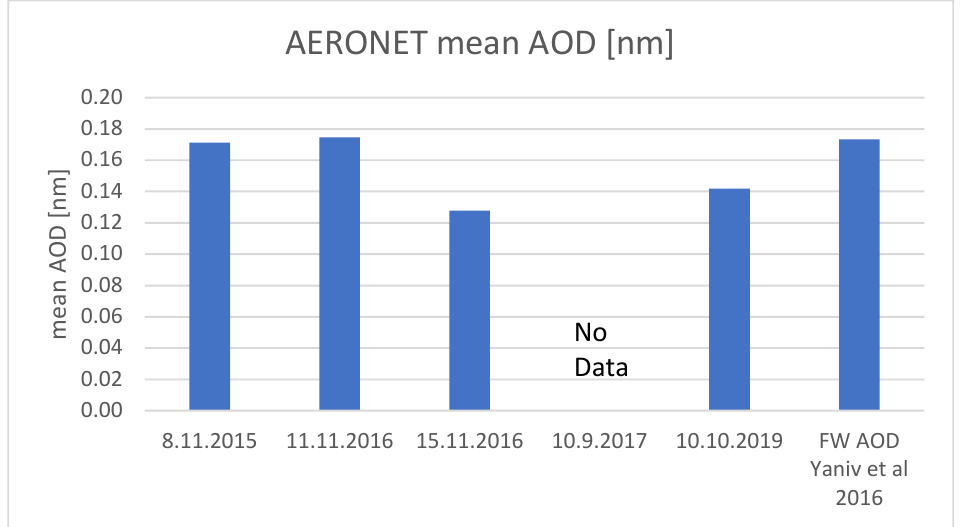
Figure 8. The AERONET mean AOD [nm] values for the different fog case studies and fair weather values obtained by Yaniv et al. (2016). FW stands for fair weather.